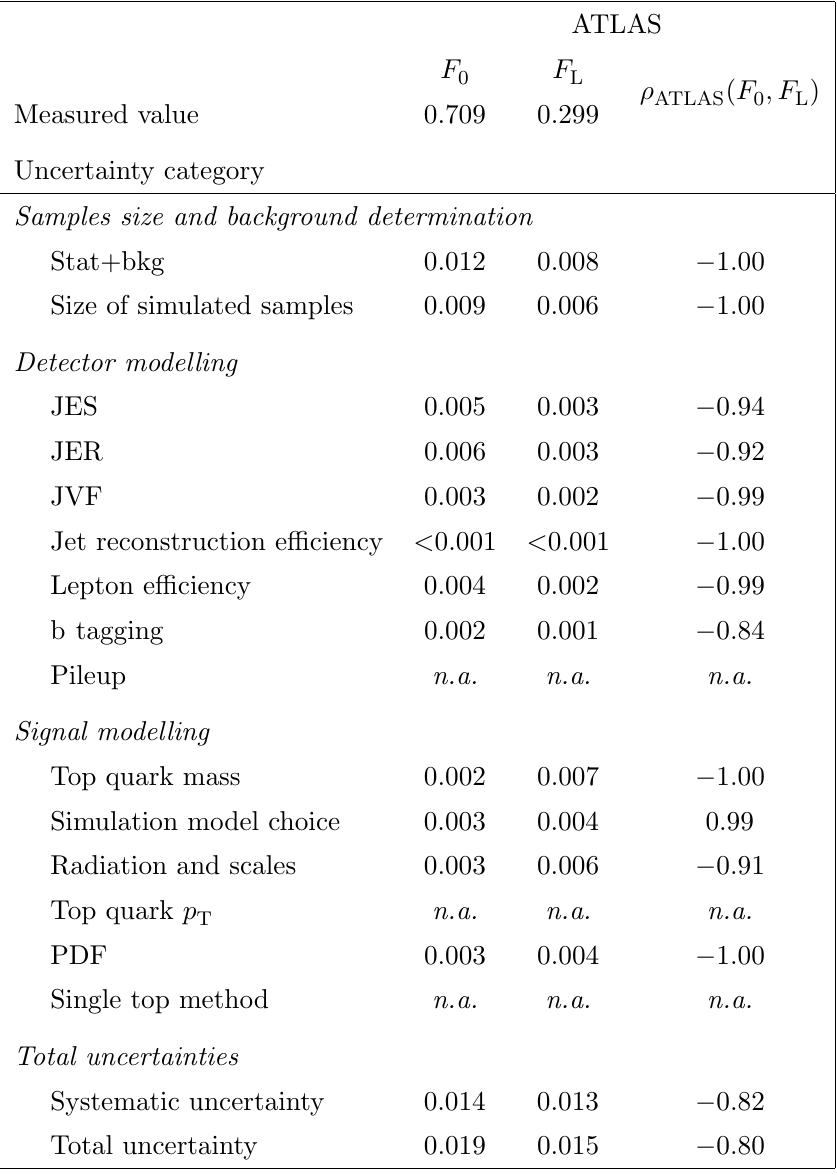
Table 2 . Uncertainties in F , F and their corresponding correlations from the ATLAS measure- 0 L ment. The uncertainty that is not applicable to this measurement, or which is included in other categories, is indicated by \ n.a. ". The line \Systematic uncertainty" represents the quadratic sum of all the systematic uncertainty sources except for the uncertainty in the background determina- tion, which is included in the \Stat+bkg" category. The quoted correlation values are obtained via the procedures described in section